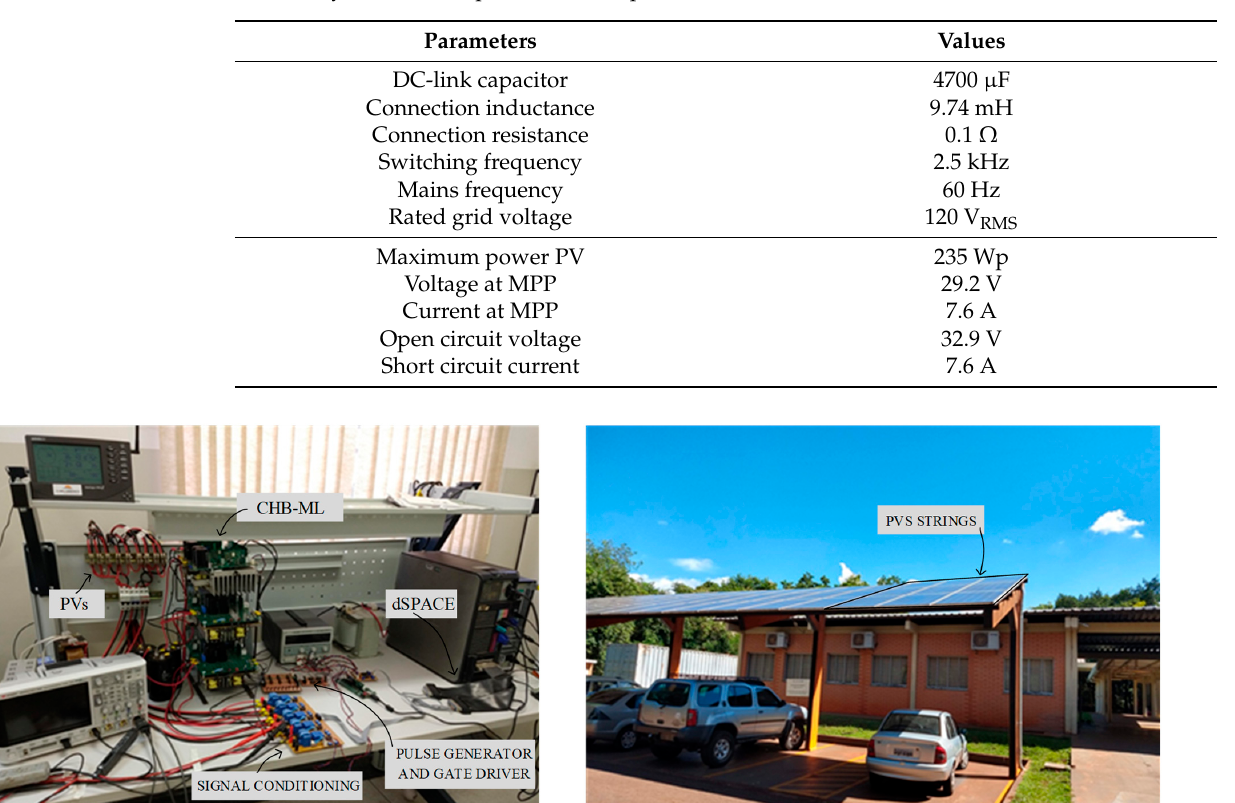
Table 2. System and PV panel electrical parameters.